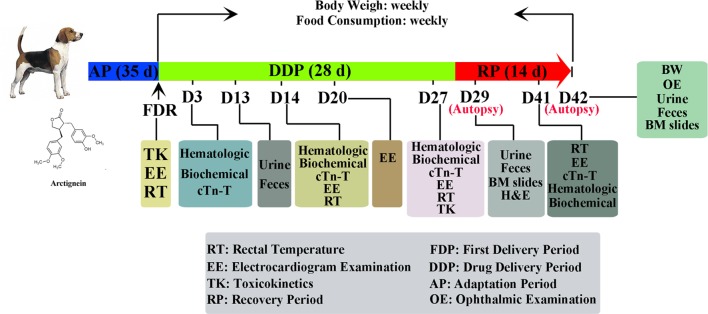
Representative experimental scheme.